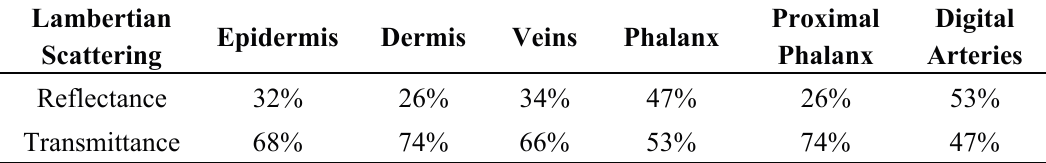
Table 2. Lambertian scattering parameters for the finger-base